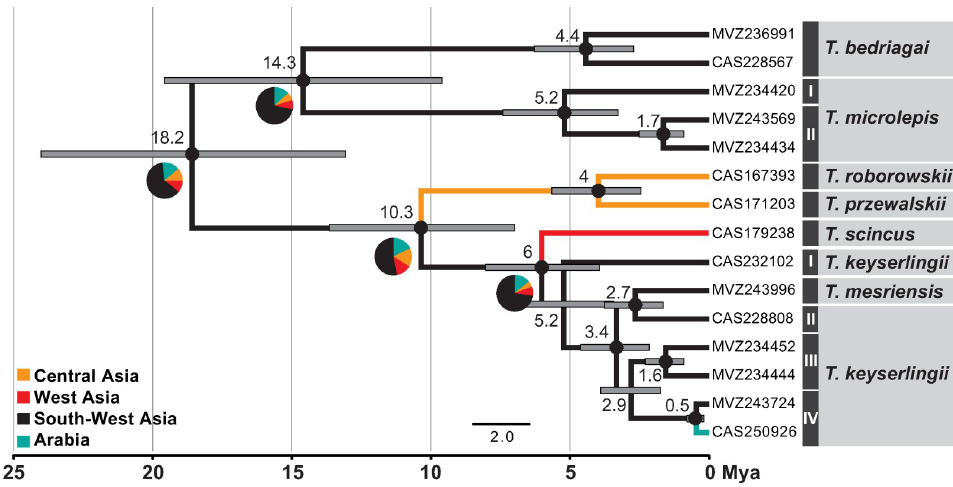
Fig 5. Ancestral area reconstructions of Teratoscincus . A Bayesian phylogenetic tree estimated using the concatenated mtDNA–nucDNA data with BSSVS. A pie chart describing the probability of each inferred area is presented near the major nodes. Branch colours indicate inferred ancestral range and the mean age estimates are provided above the nodes with horizontal bars representing the 95% highest posterior densities. Black circles represent nodes with posterior probability values �